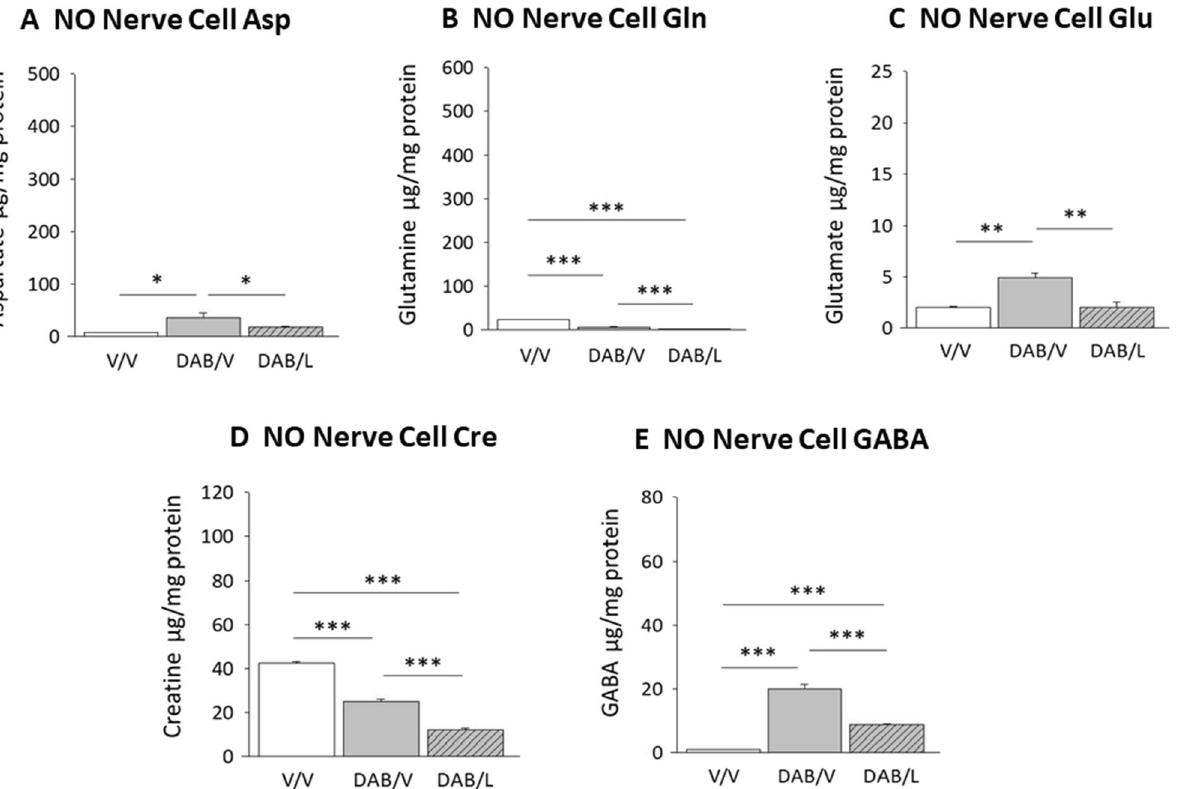
Figure 3. Effects of DAB with or without l-lactate on VMN nitrergic glucogenic amino acid homeostasis. Data show mean NO nerve cell Asp ( A ), Gln ( B ), Glu ( C ), Cre ( D ), and GABA ( E ) concentrations ± S.E.M. for the following treatment groups: V/V (solid white bars); DAB/V (solid gray bars); DAB/lactate (diagonal-striped gray bars). * p < 0.05, ** p < 0.01, *** p <